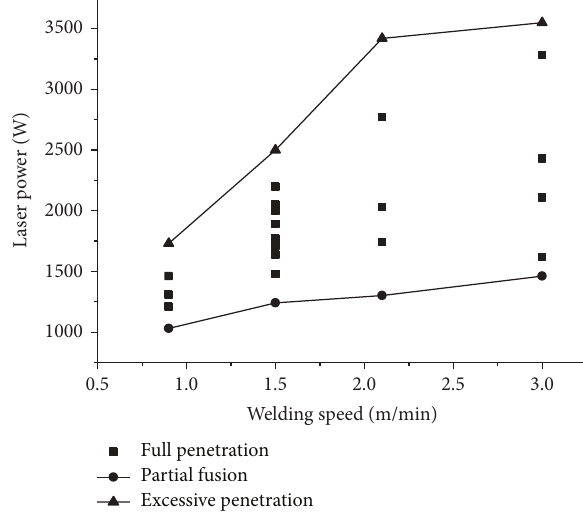
Figure 9: Influence of laser power and welding speed on formation of weld. ( 𝑃 = 1030 ∼ 3550 W; 𝑉 = 0.9 ∼ 3 m/min; Δ𝑍 = 0 mm; 𝑈 𝑓 = 15